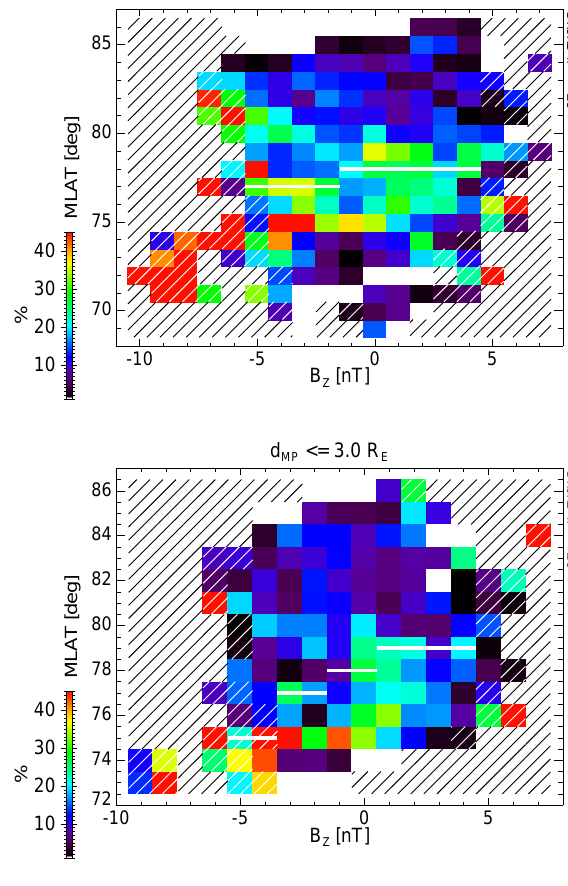
Fig. 4. The cusp location as a function of the IMF B Z component. The bottom part presents cusp observations near the model magne- topause ( d MP ≤ 3 R E